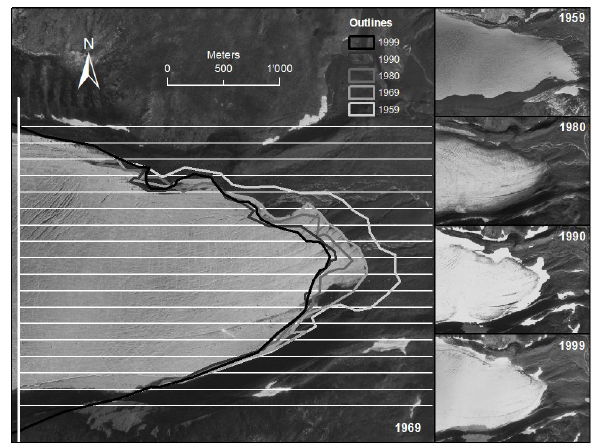
Fig. 3. Frontal retreat of Storglaci¨aren as derived from the orthopho- tos. The average retreat rates are derived from the intersection of the glacier outlines with the band of stripes. Note the perennial snow banks in front of the glacier in the images of 1990 and